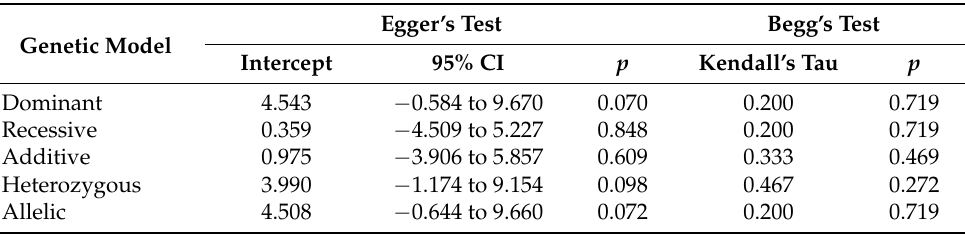
Table 2. The results of Egger’s and Begg’s tests for all genetic models between the studies analysing stroke patients and